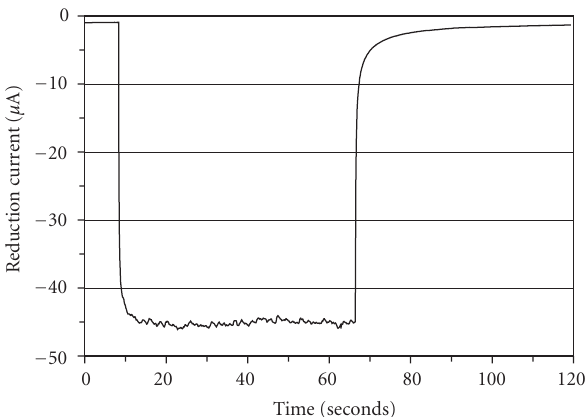
Figure 7: Electrochemical response of a solution of 0.01M KOH exposed to a 1.28nA alpha beam for 58 seconds.